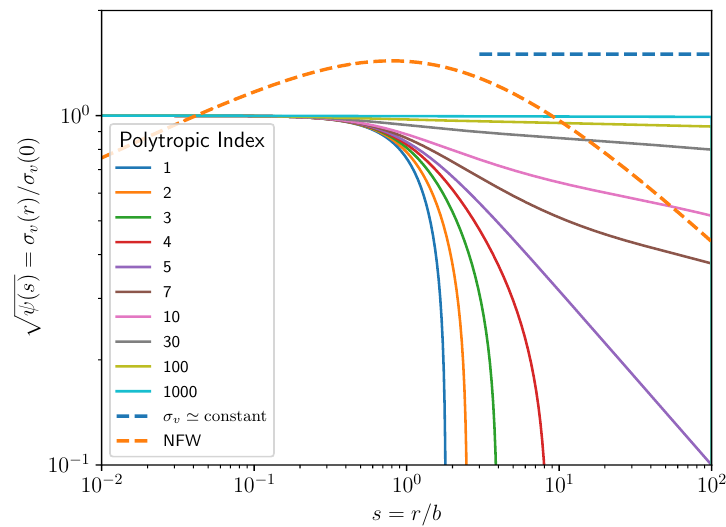
Figure 2. Velocity dispersion corresponding to the polytropic radial density variation represented in Figure 1. These curves just provide the shape of the profile, which can be shifted horizontally and vertically by arbitrary amounts (set by the constants b and σ v ( 0 ) , respectively). The color code is the same as that used in Figure 1. The curve with m = 1000 approximately models the shape of an isothermal sphere. For reference, the plot includes σ v (cid:39) constant (the blue dashed line), which represents the asymptotic behavior of high- m polytropes, and also shows the velocity dispersion of the NFW profile in Figure 1 (as worked out in [56]). Note the huge difference in dynamical range between the radial density variations ( ∼ 10 6 ; Figure 1) and the corresponding velocity dispersion variations shown in this figure ( ∼